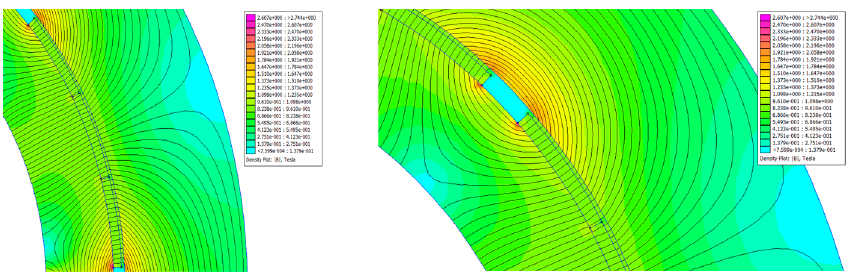
Figure 7. Two views of the rotor magnetic field in one motor pole.